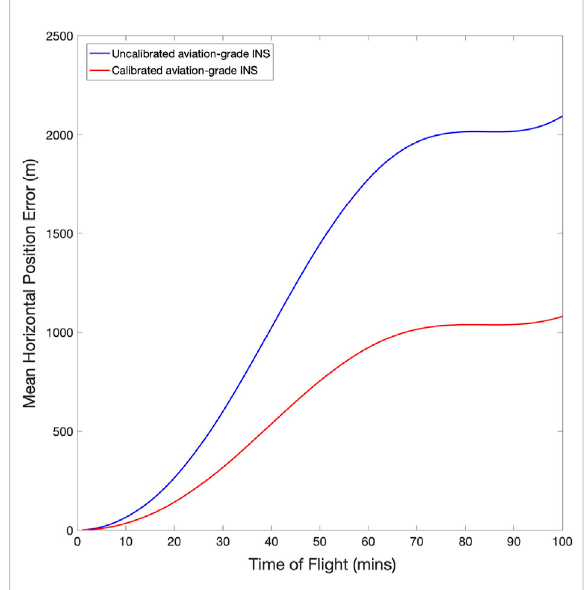
FIGURE 2 Mean horizontal error for route Brighton-Edinburgh for an uncalibrated aviation-grade INS solution (blue) and an aviation- grade INS that is calibrated online by a perfectly aligned set of perfect cold atom sensors (red) — mean is calculated over 50 realisations of the errors for the full